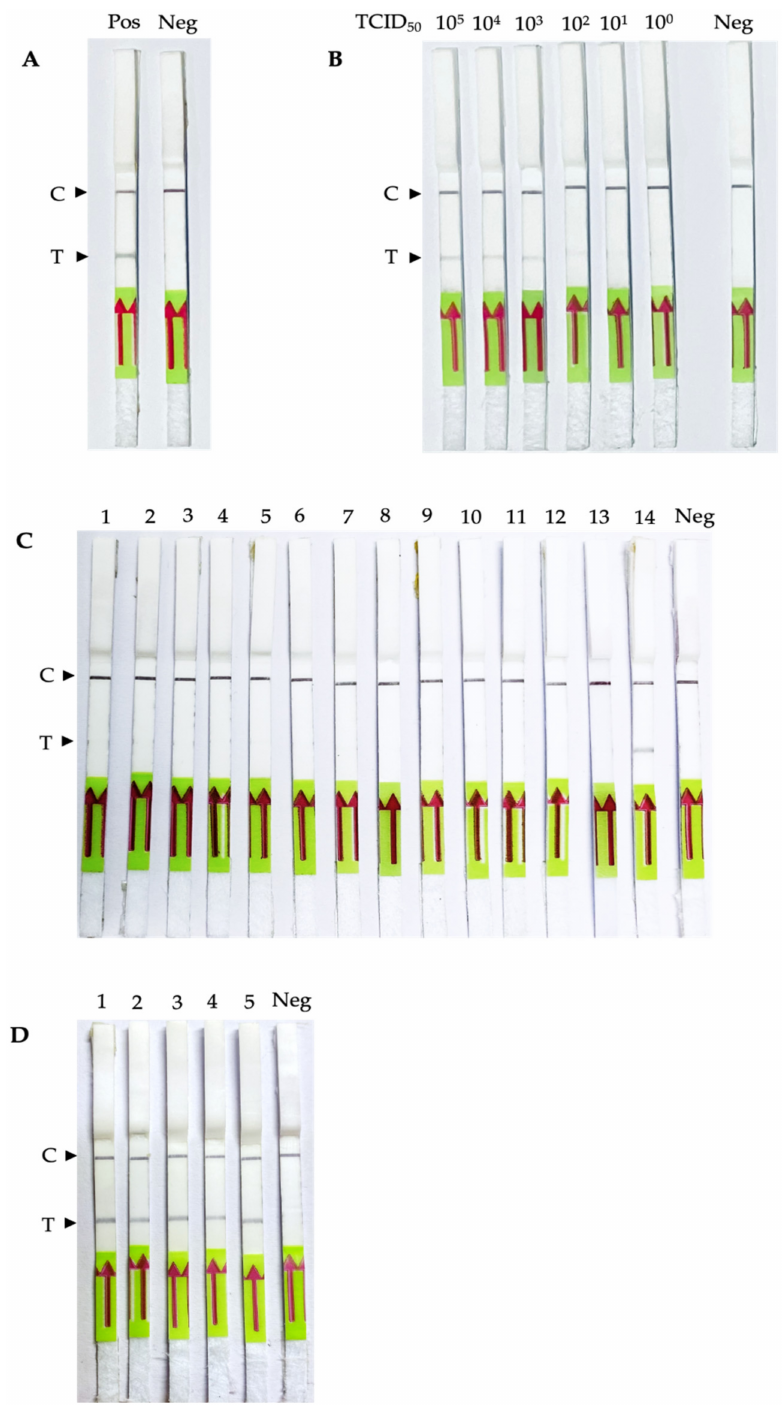
Figure 3. Sensitivity, Specificity and Usability of PEDV RT-RPA-NALF assay. ( A ) PEDV detection by RT-RPA-NALF. Pos: RT-RPA product from extracted PEDV RNA; Neg: negative control, RT-RPA product without template. ( B ) Sensitivity of the RT-RPA-NALF assay. To determine the detection limit of the RT-RPA-NALF assay, tenfold serial dilutions of the RNA standard ranging from 10 5 TCID 50 /mL to 10 0 TCID 50 /mL (varied from 10 5 , 10 4 , 10 3 , 10 2 , 10 1 , and 10 0 ; Neg: negative control) were evaluated. ( C ) Specificity test of the RT-RPA-NALF assay. The nucleic acids of 14 common swine pathogens were used to validate the cross-reactivity of the RT-RPA-LFD assay and replicated testing for